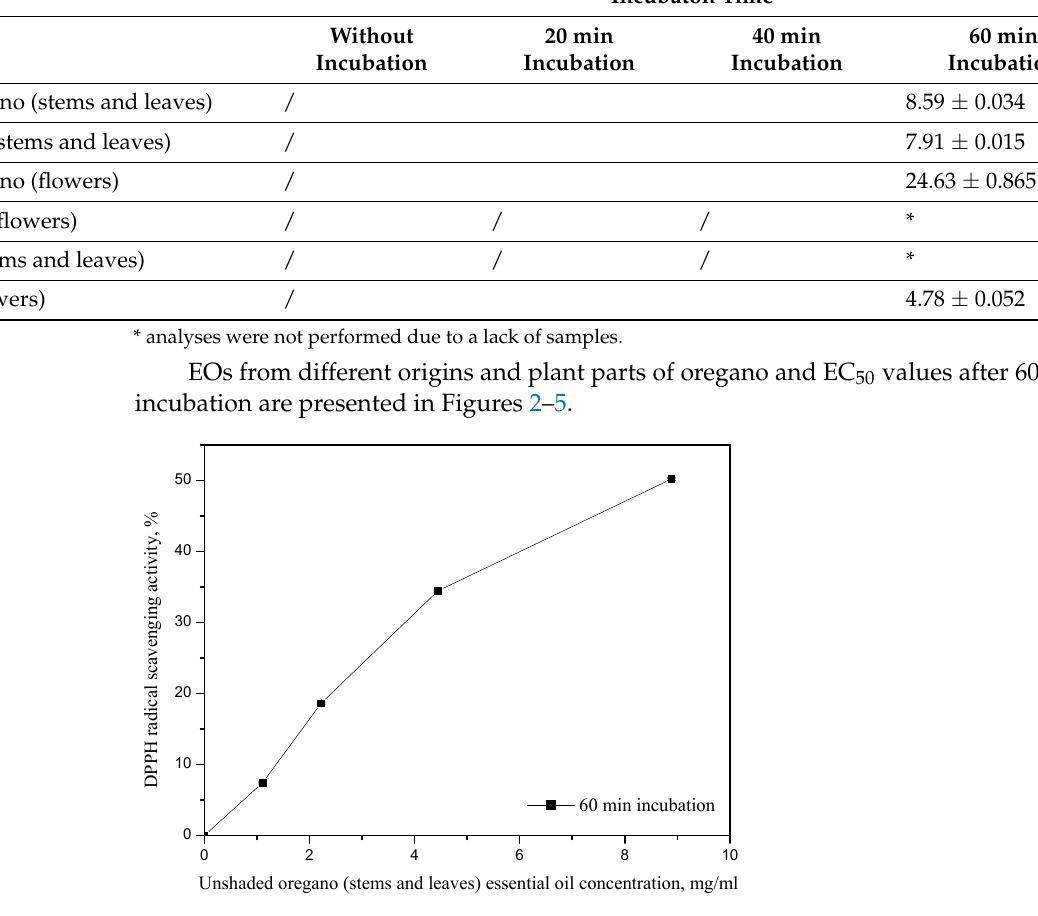
Figure 2. Antioxidant activity of nonshaded oregano (stems and leaves) essential oil.